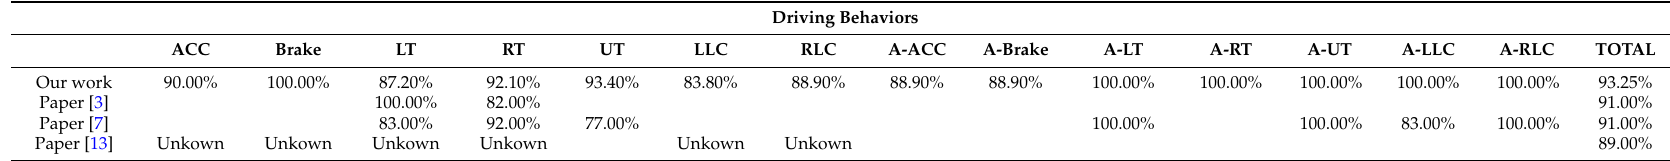
Table 7. A comparison between this article and other papers.